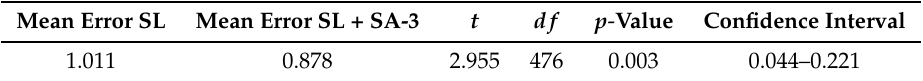
Table 3. Mean Error of predictive models using DMA SL and DMA combination SL + SA-3. Comparison by Student’s t -test for equality of means.